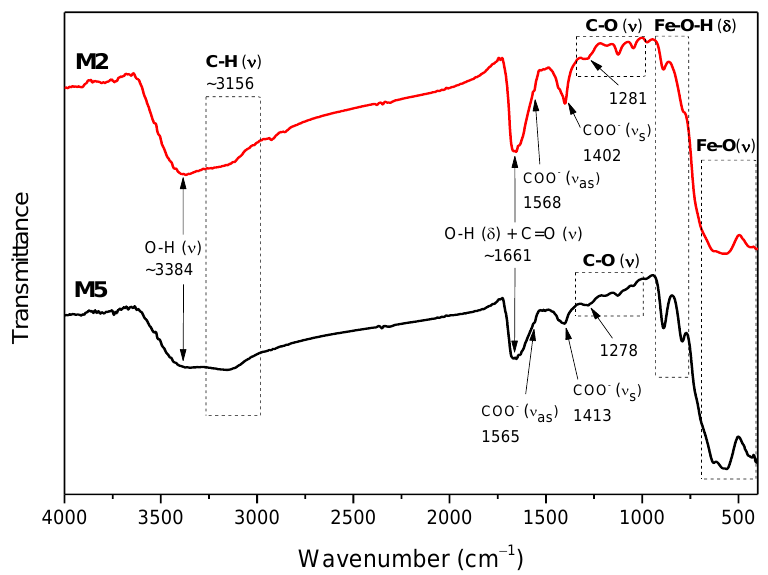
Figure 4. FTIR spectra of the M2 and M5 samples. The peaks positions are indicated in cm −1 .